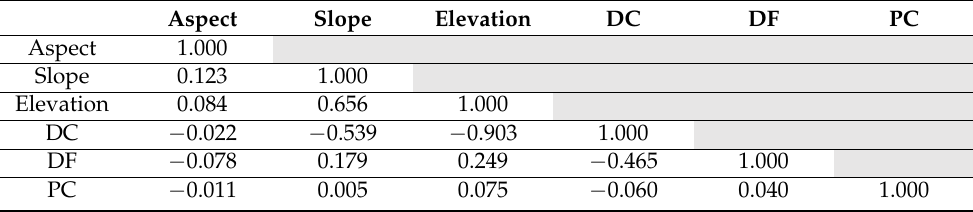
Table 4. Spearman’s correlation results from initial explanatory variables. DC: Distance from crater; DF: Distance from surviving forest; PC: Profile